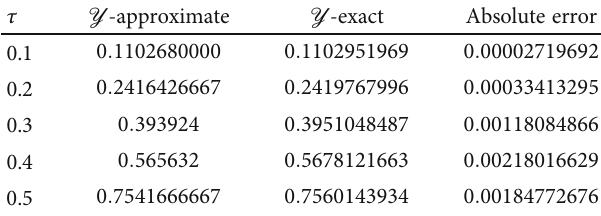
Table 1: Numerical results of the Riccati equation in Example 1.